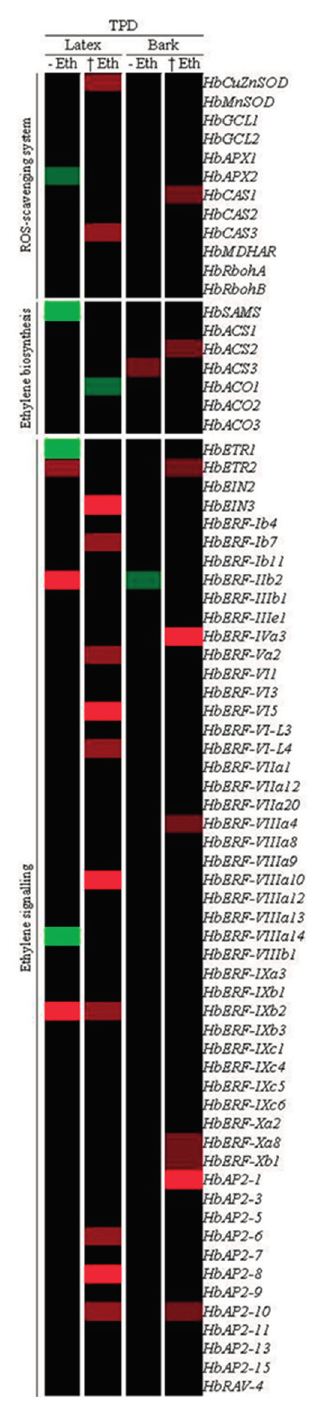
Figure 9. Fold change profile of 70 genes of Hevea brasiliensis involved in reactive oxygen species (ROS)-scavenging system, ethylene biosynthesis and signalling during the occurrence of Tapping Panel Dryness (TPD) in 6-year-old mature trees. Values are ratio between TPD and healthy plants without ( − Eth) or with ethephon (+Eth) stimulation for six biological replicates. Values of relatives transcript abundance was performed with an ANOVA followed by the Student Newman–Keuls test. Upregulated genes were shown in bright red for a threshold value ≥ 5; dark red for value <5, and down-regulated genes were shown in bright green for a threshold value ≤ 0.2; dark green for value >0.2. The non-significant genes are shown in dark